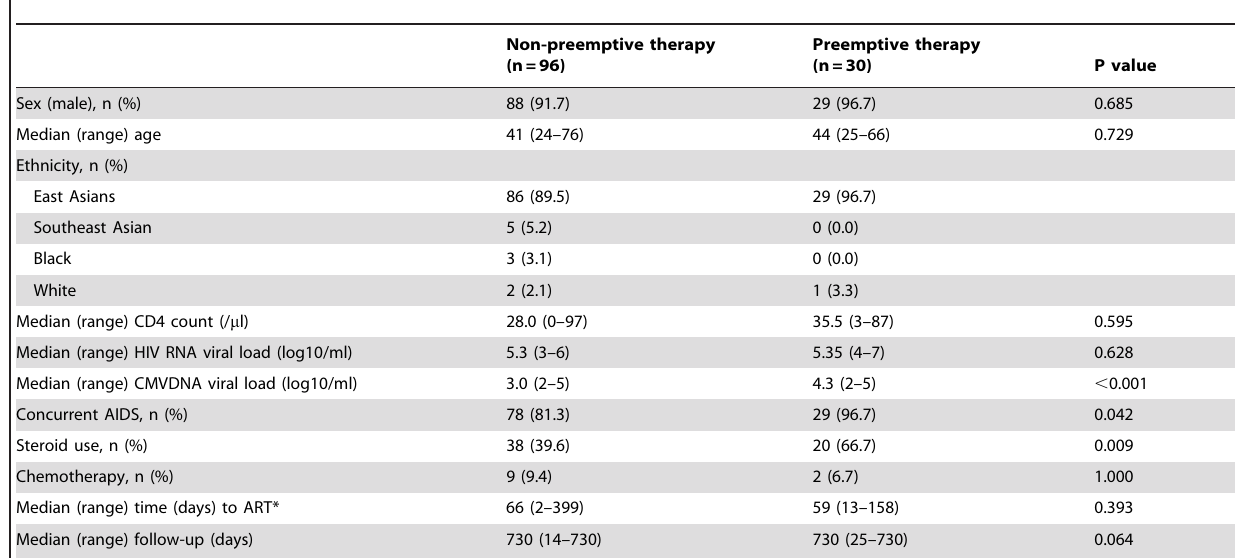
Table 1. Baseline demographics and laboratory data of patients who did and did not receive CMV preemptive